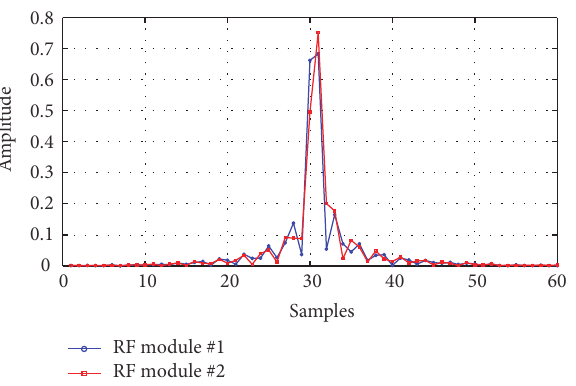
Figure 4: Impulse responses of the 2 RF modules.